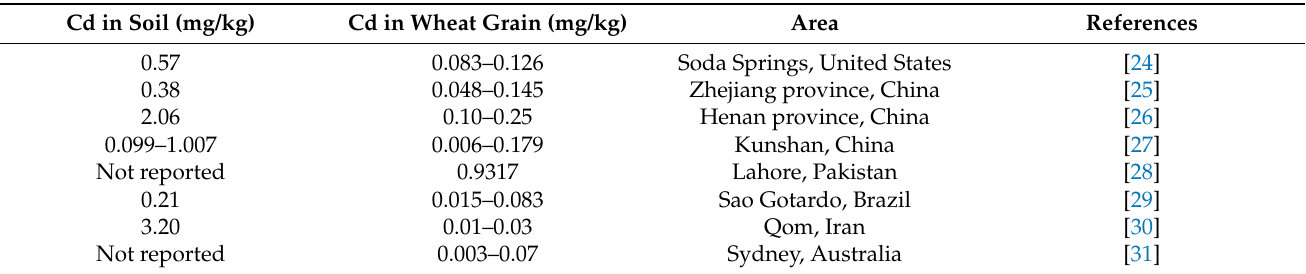
Table 1. Cd content in soil and wheat worldwide.